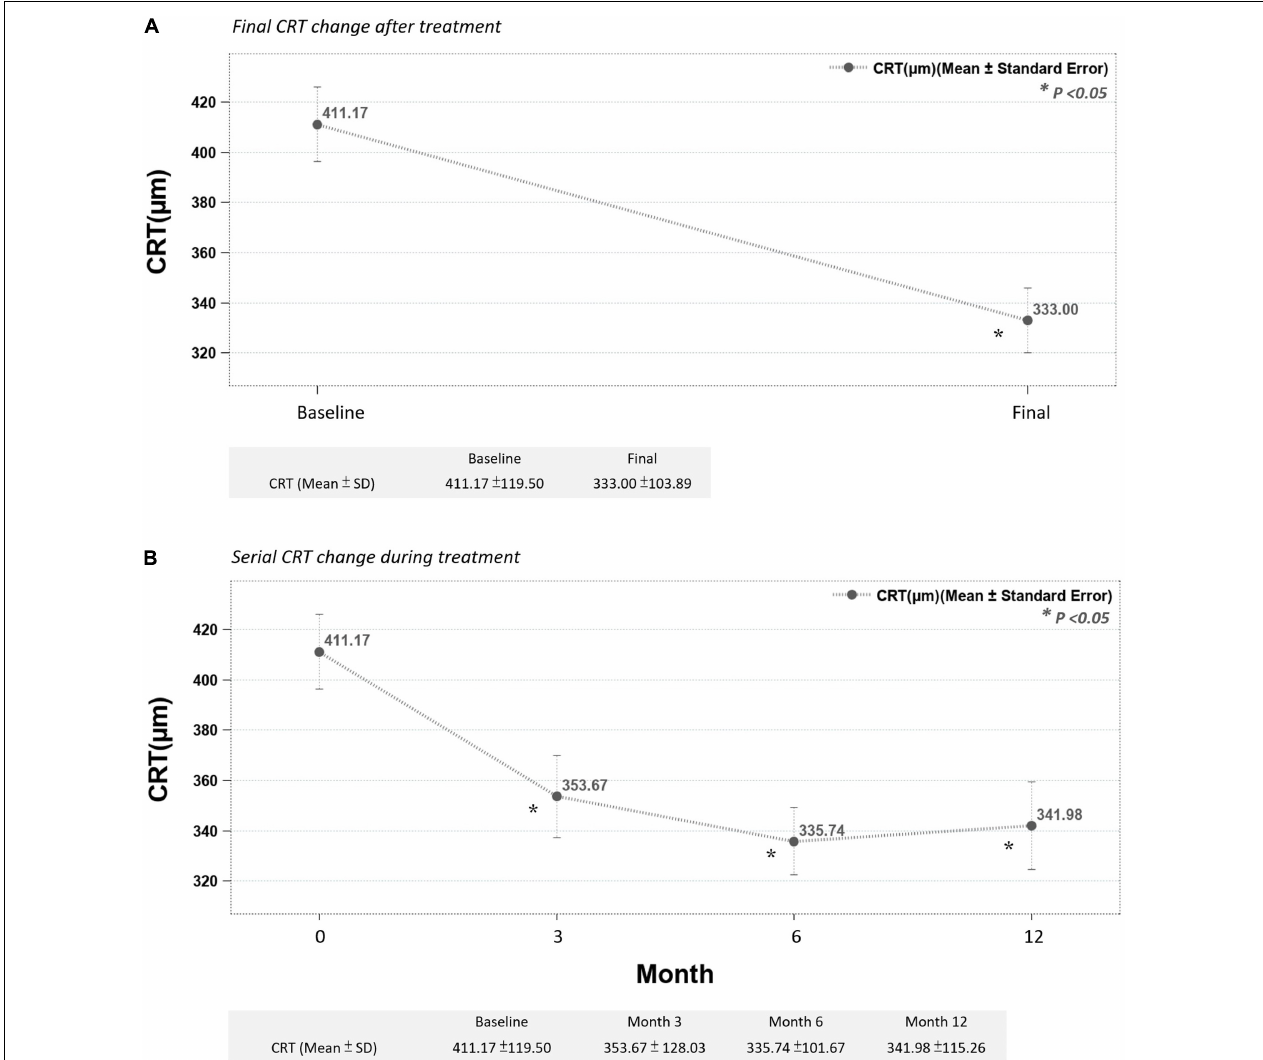
FIGURE 2 | (A) Final CRT significantly improved after treatment. (B) Mean CRT improved significantly after the third month and continuously improved up to the end of the study (month 12) (* p < 0.05 compared to before-treatment